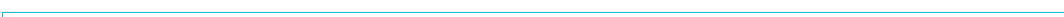
Figure 1: Overview of relevant stakeholders in Switzerland at the federal, cantonal, and local/private level with regard to collection of data on agricultural workers, including PPP use and exposures, and occupational and public health indicators related to adverse health effects. These stakeholders may be involved in PPP regulation and risk assessment (e.g., SECO, FOAG, FOPH), implement agricultural policies (e.g., SAVI, Prometerre SA, SSP of VAUD, Agroscope), provide health insurance (e.g., SUVA, private insurance companies), provide education and advi- sory services for workers (e.g., SPAA, SUVA, AGRIDEA, IST) as well as healthcare to patients (e.g., medical care providers, IST), or, conduct research or gather/analyze existing data (e.g., IST, FOS). We contacted all the stakeholders presented in figure 1 for an